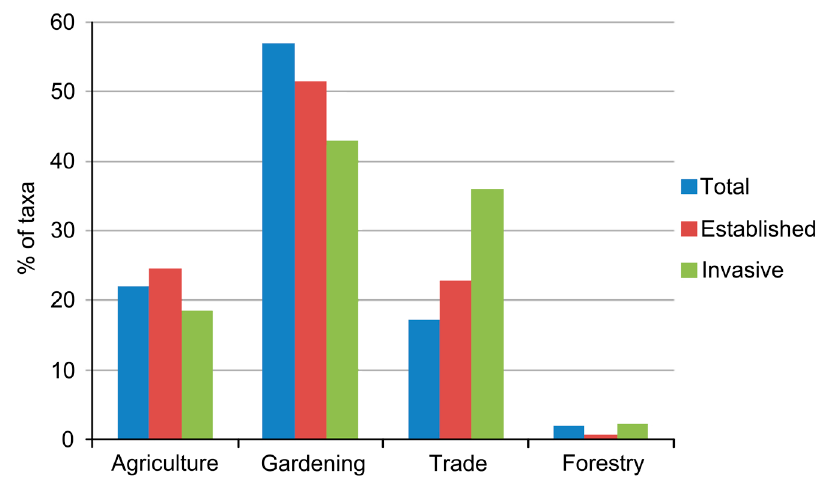
Figure 7. Proportional contribution of the most important inferred pathway of introduction to the alien flora of Catalonia.